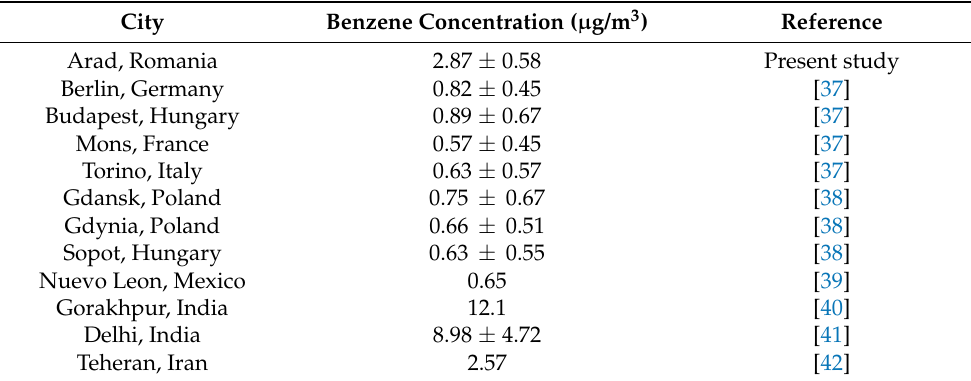
Table 4. The average concentration of benzene in different